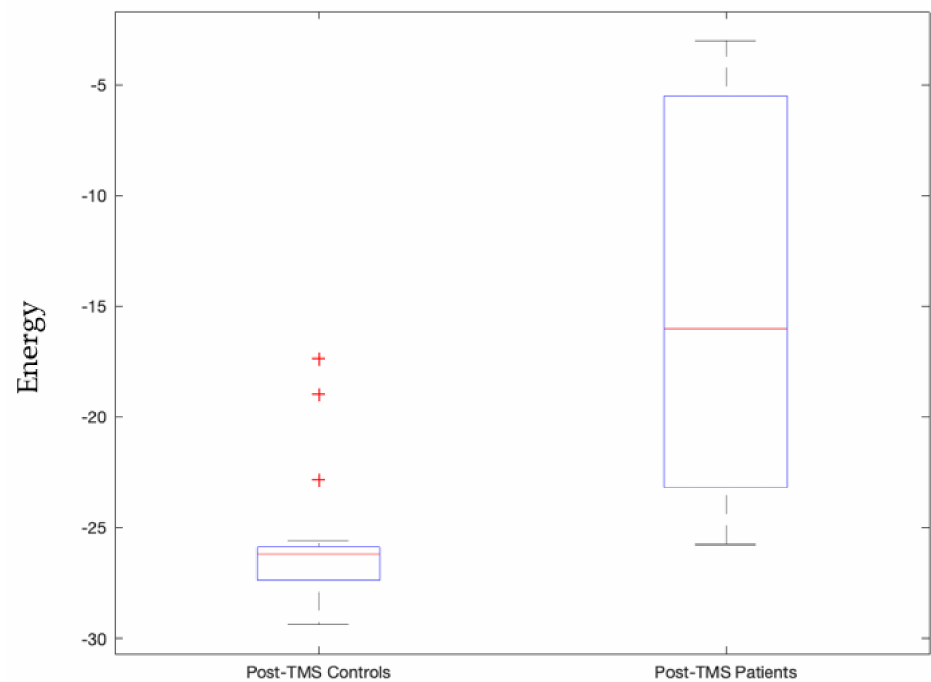
Figure 8. Energy values of controls significantly differed from patients during post-TMS subthreshold pulse stimulation condition with a p -value = 0.0000015 for the active salience network energy state. TMS subthreshold pulse was administered at the